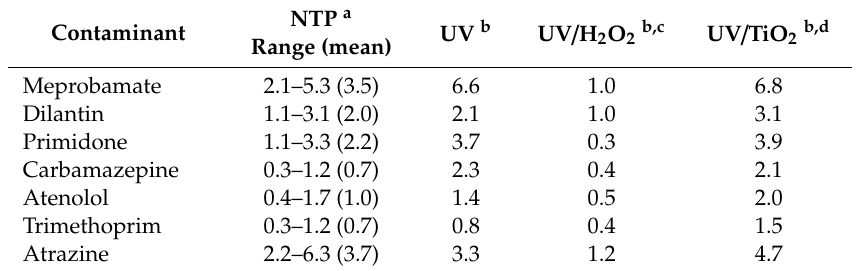
Table 6. Specific EEO values for di ff erent AOPs applied to some contaminants of interest on the same water matrix (spiked Lake Mead surface water, kWh m − 3 order − 1 ) (data from [34]).